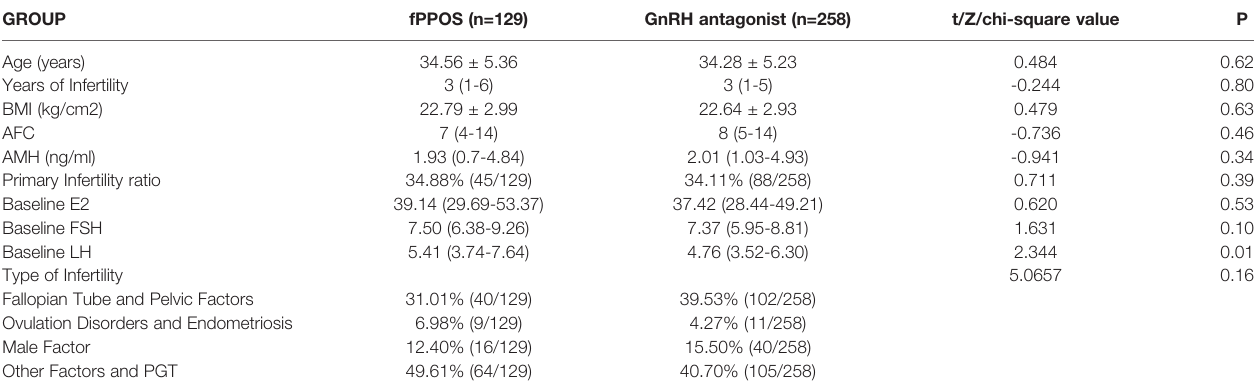
TABLE 1 | Baseline characteristics of the study population.